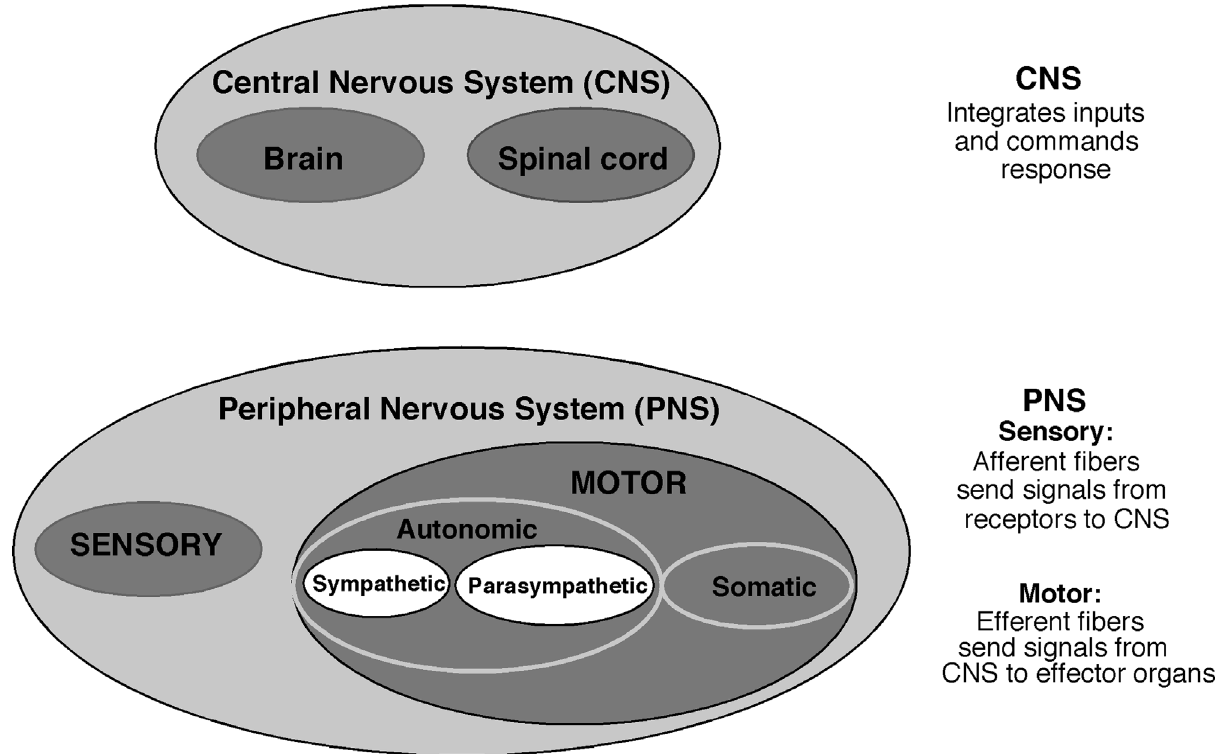
Figure2 -SimplifiedschematicrepresentationoftheNervousSystem.TheCentralNervousSystem(CNS),consistsofbrainandspinalcord,receivesin- putsfromthePeripheralNervousSystem(PNS)afferent(sensory)fibers,integratesthesignalsandcommandstheresponseviatheefferent(motor)fibers of the